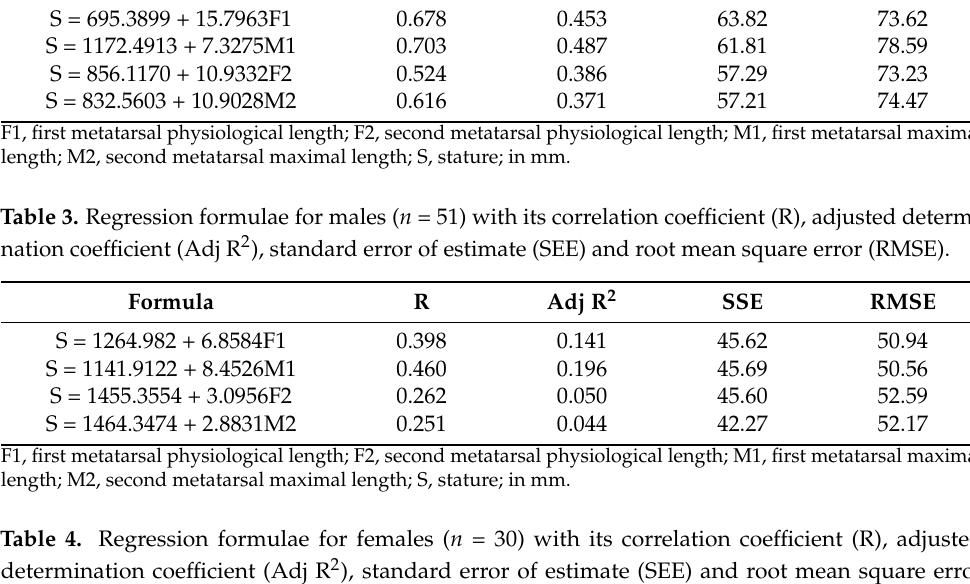
Table 2. Regression formulae for all (unknown sex, n = 81) with its correlation coefficient (R), adjusted determination coefficient (Adj R 2 ), standard error of estimate (SEE) and root mean square error (RMSE). Formula R Adj R 2 SSE RMSE S = 695.3899 + 15.7963F1 0.678